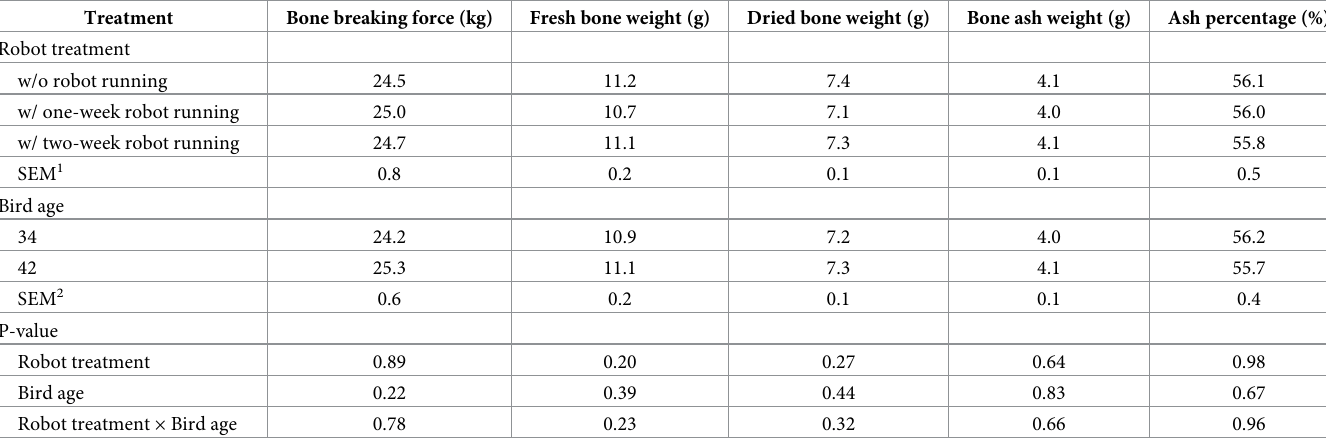
Table 6. Means of bone breaking force, fresh bone weight, dried bone weight, bone ash weight, and ash percentage under the treatments.